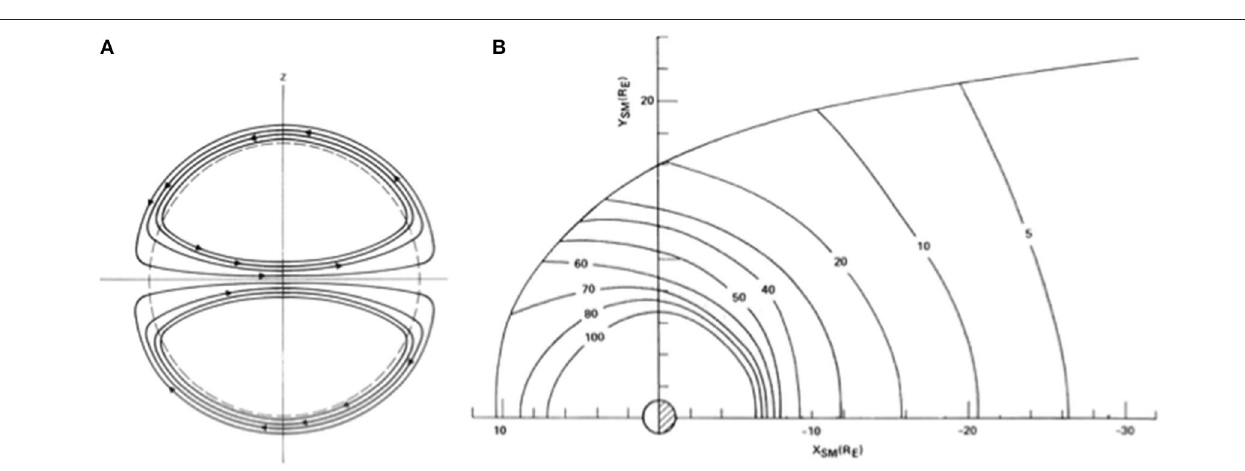
FIGURE 6 | One of the directly driven (DD) current systems generated by the solar wind-magnetosphere dynamo; (A) in the vertical cross-section of the magnetosphere, there are two solenoidal currents. (B) the equatorial part of the solenoidal currents (Olson, 1984). As we discuss later, the current crossing the magnetosphere just outside the closed or circular current [ring current] plays a crucial role in producing auroral substorms (section A possible process for generating the earthward electric field)